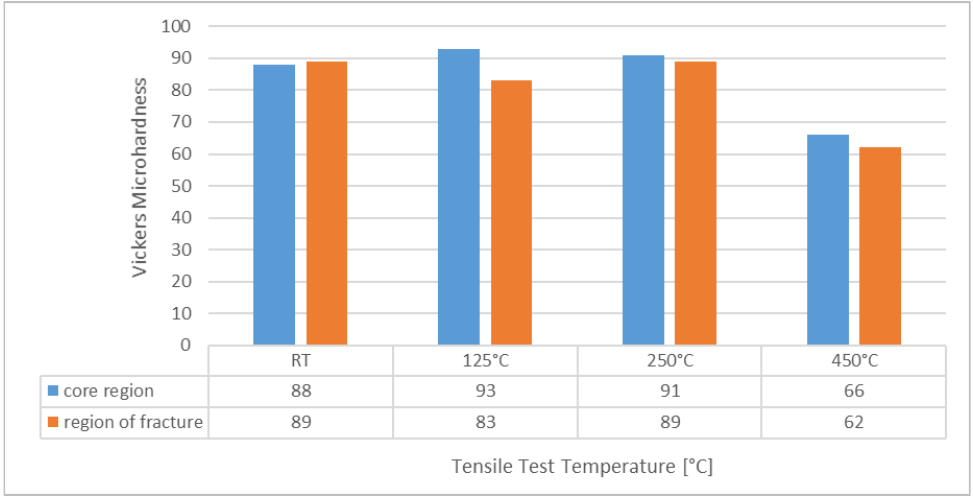
Figure 15. Microhardness measured near the fracture surface and in the sample core for specimens of polar angle 0° tested at room temperature (RT), 125, 250 and 450 °C. Note that the hardness measurements themselves were performed at room temperature.